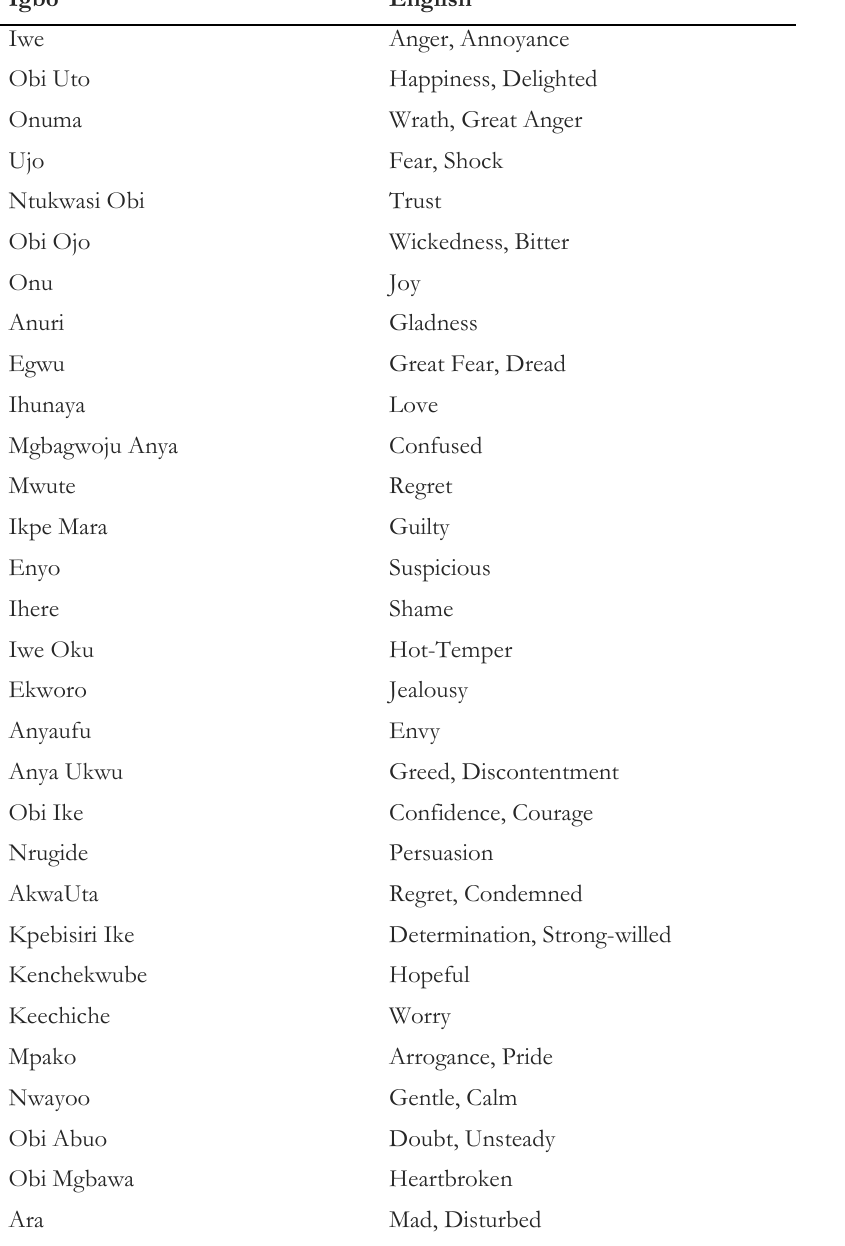
Table 1. The Igbo emotion words and the english